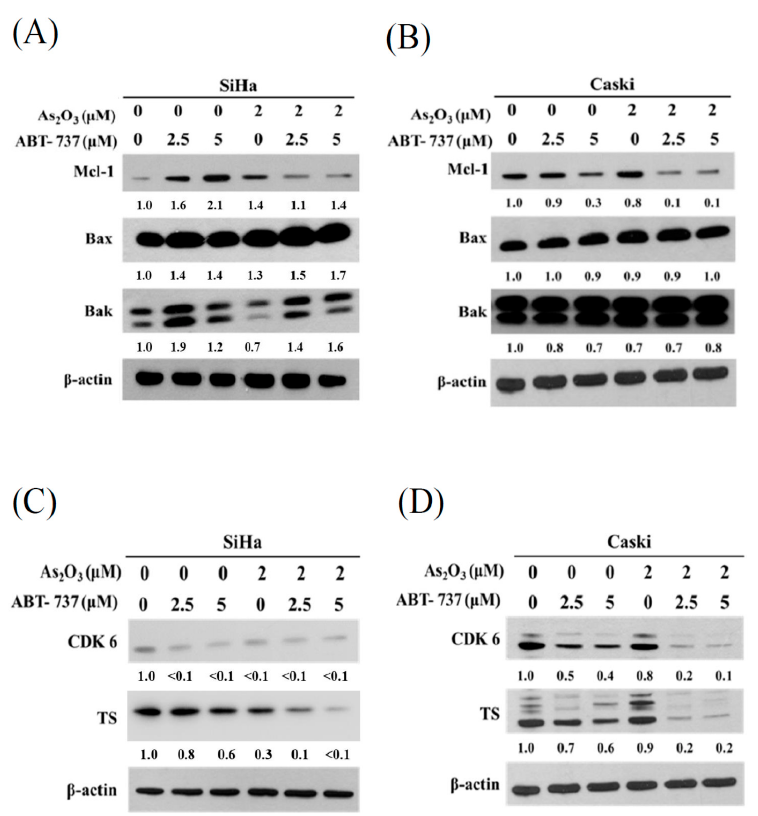
Figure 4. Effects of ABT-737 combined with As 2 O 3 on reactive oxygen species (ROS) production in cervical cancer cells. SiHa cells (4 × 10 5 cells/6 cm dish) and Caski (4 × 10 5 cells/6 cm dish) were co-treated with ABT-737 and As 2 O 3 for 8 h. After treatment, the cells were stained with 2 ′ ,7 ′ -dichlorodihydrofluorescein diacetate (H2DCFDA) dye to detect the production of ROS by flow cytometry.